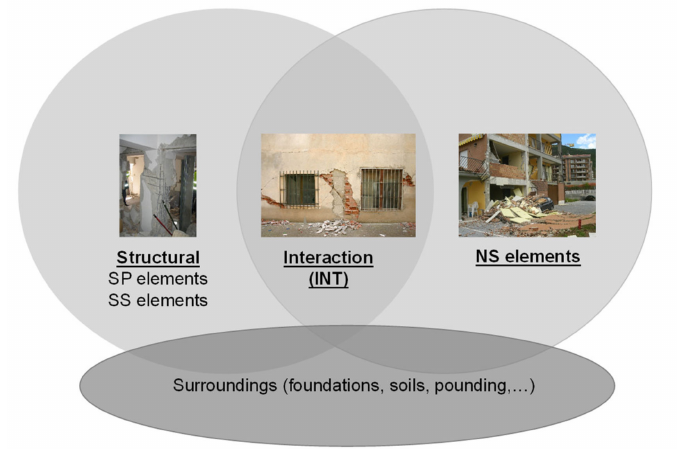
Figure 3. Interaction between the most common damages observed in RC structures due to